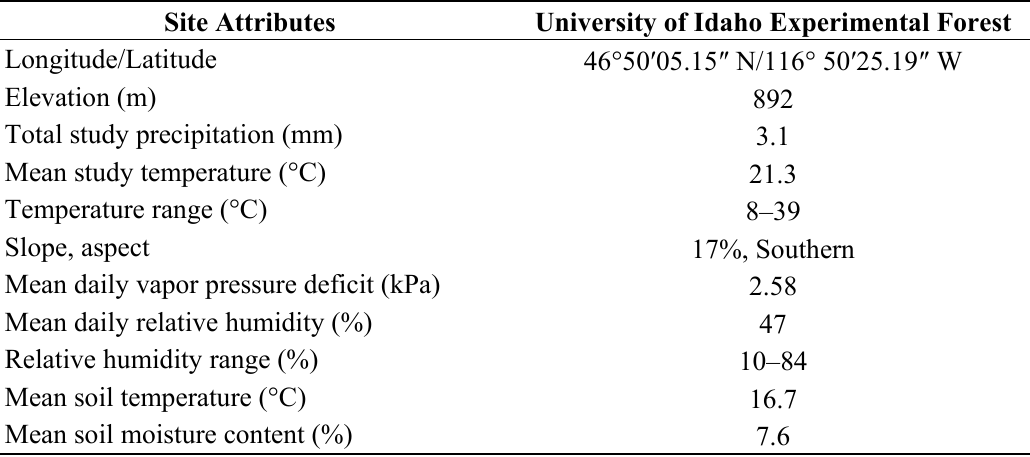
Table 1. Site characteristics during study